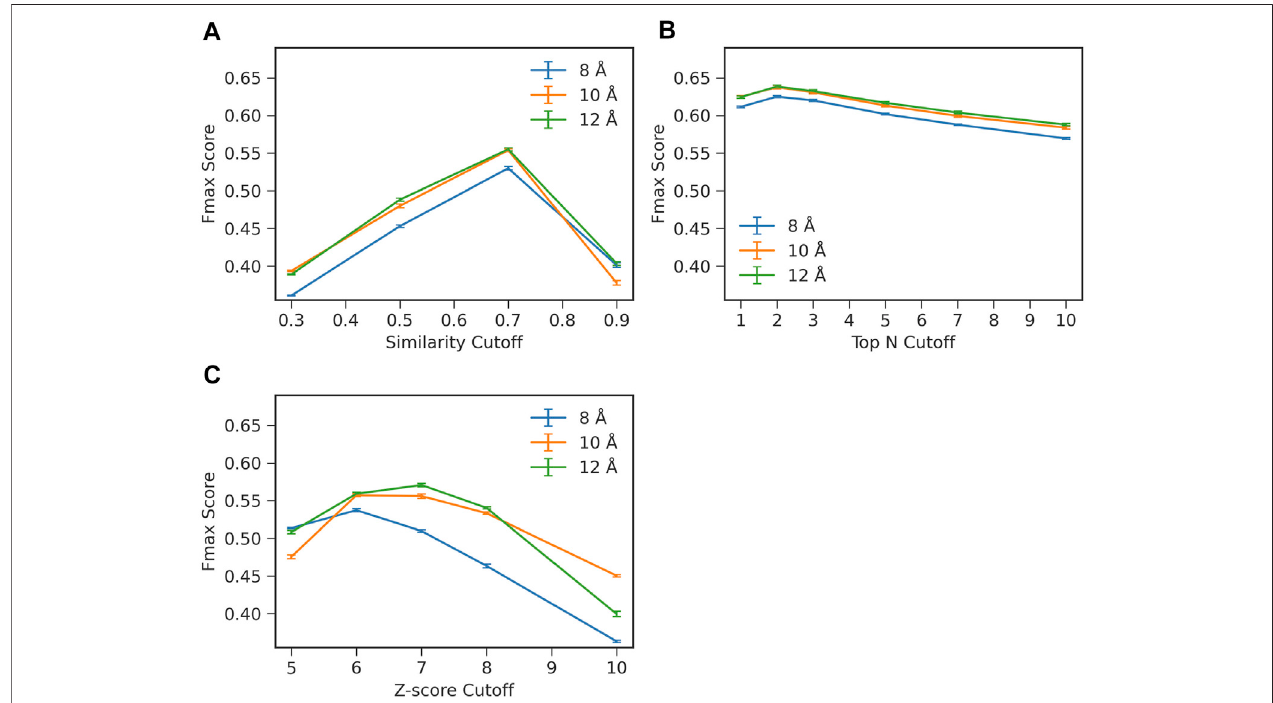
FIGURE 2 | In fl uence of parameters on the prediction performance of ContactPFP. Parameters were examined that determine the de fi nition of hits in the contact mapdatabasesearch.They-axisshownistheaverageFmaxscorecomputedforthefourtestsetsinthefour-foldcrossvalidation.Ineachplot,threedistancecutoffs,8, 10, 12 (cid:1) A, were used that de fi ned residue contacts. The bar indicates the standard deviation calculated from four-fold cross validation. (A) Raw contact map graph comparison score. From a database search result, we only considered retrieved proteins with a speci fi ed graph similarity score or higher. The average standard deviation was 0.002. (B) Selecting top N hits by the raw score. In this scheme, we only selected top N hits as speci fi ed on the x-axis regardless of their scores. The average standard deviation was 0.002. (C) Z-score of the contact map graph comparison score. In this scheme, we chose hits to consider by the Z-score of the graph